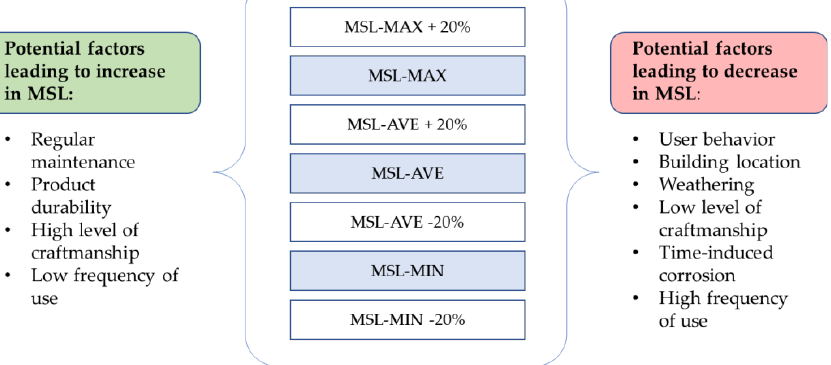
Figure 10. MSL variations and potential factors.